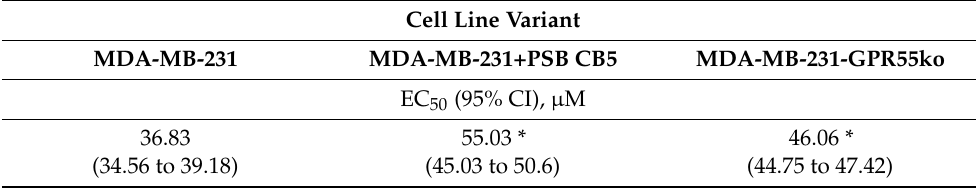
Table 4. Cytotoxicity of DHA-DA for the original cell line MDA-MB-231, cells in the presence GPR18 blocker PSB CB5 (3 µ M) and the variant of with knockout GPR55, incubation time 24 h, MTT test data.